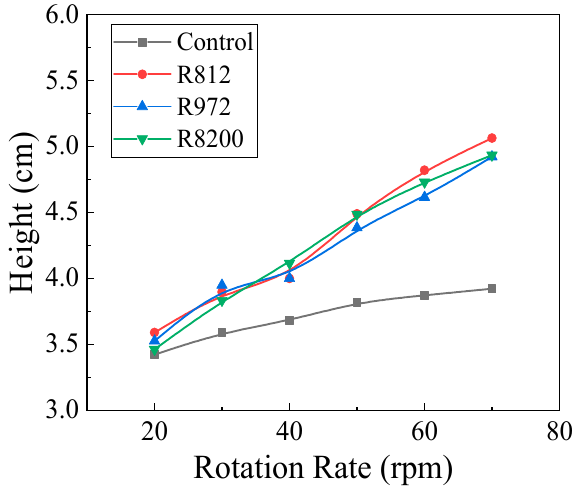
Figure 6. Bed expansion of polyester powder samples.